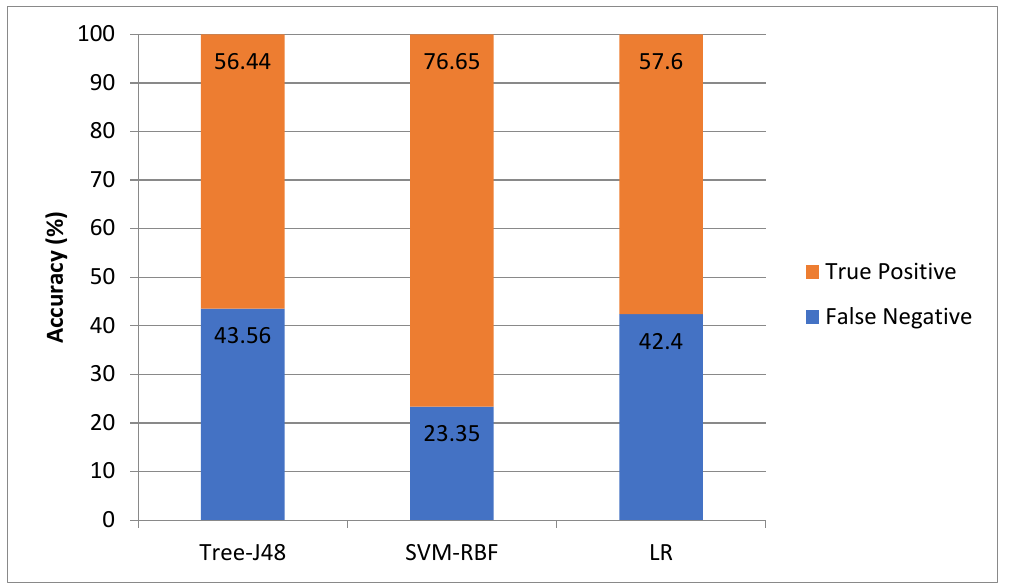
Figure 5. Rates of true negative and true positive .